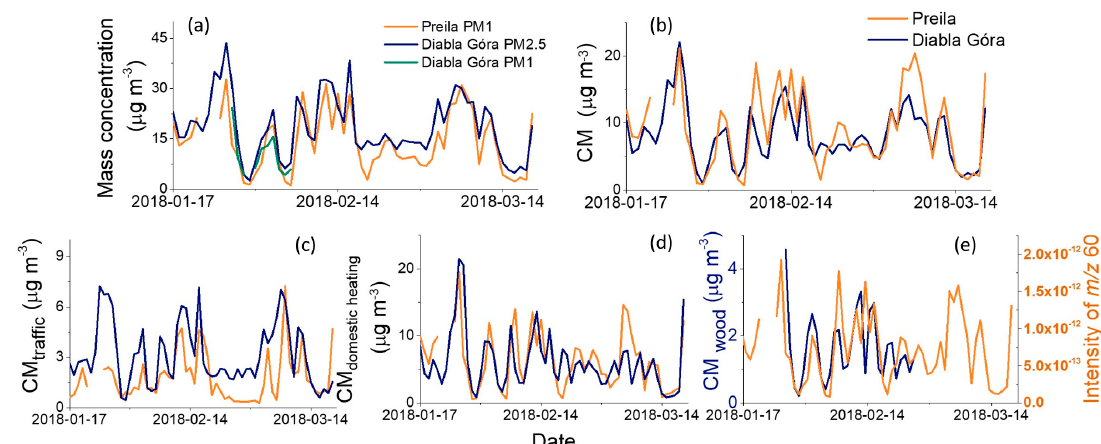
Figure 6. Timeseries for Diab ł a Góra (blue) and Preila (orange). ( a ) PM 1 (Preila and Diab ł a Góra) and PM 2.5 (Diab ł a Góra). ( b ) Carbonaceous matter (CM) PM subfraction. ( c ) Traffic contribution to CM. ( d ) domestic heating contribution to CM. ( e ) wood burning contribution (subcategory of domestic heating) for Diab ł a Góra on the left y-axis. Right Y-axis shows ACSM signal intensity at m/z 60 for Preila, which is used to indicate wood burning influence.